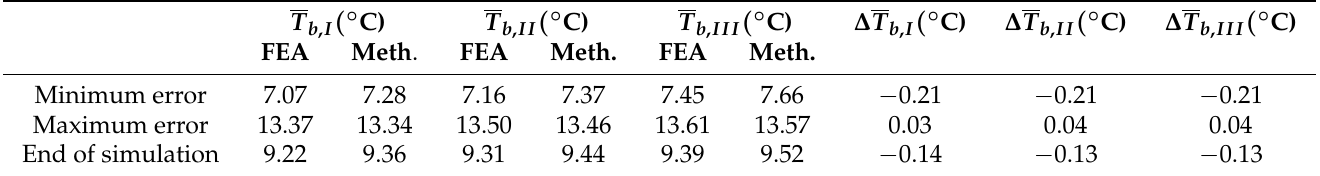
Figure 11. Comparison of predicted borehole wall temperatures for each equivalent group ( I , II , III ) Table 4. Errors on borehole wall temperatures during the 10th